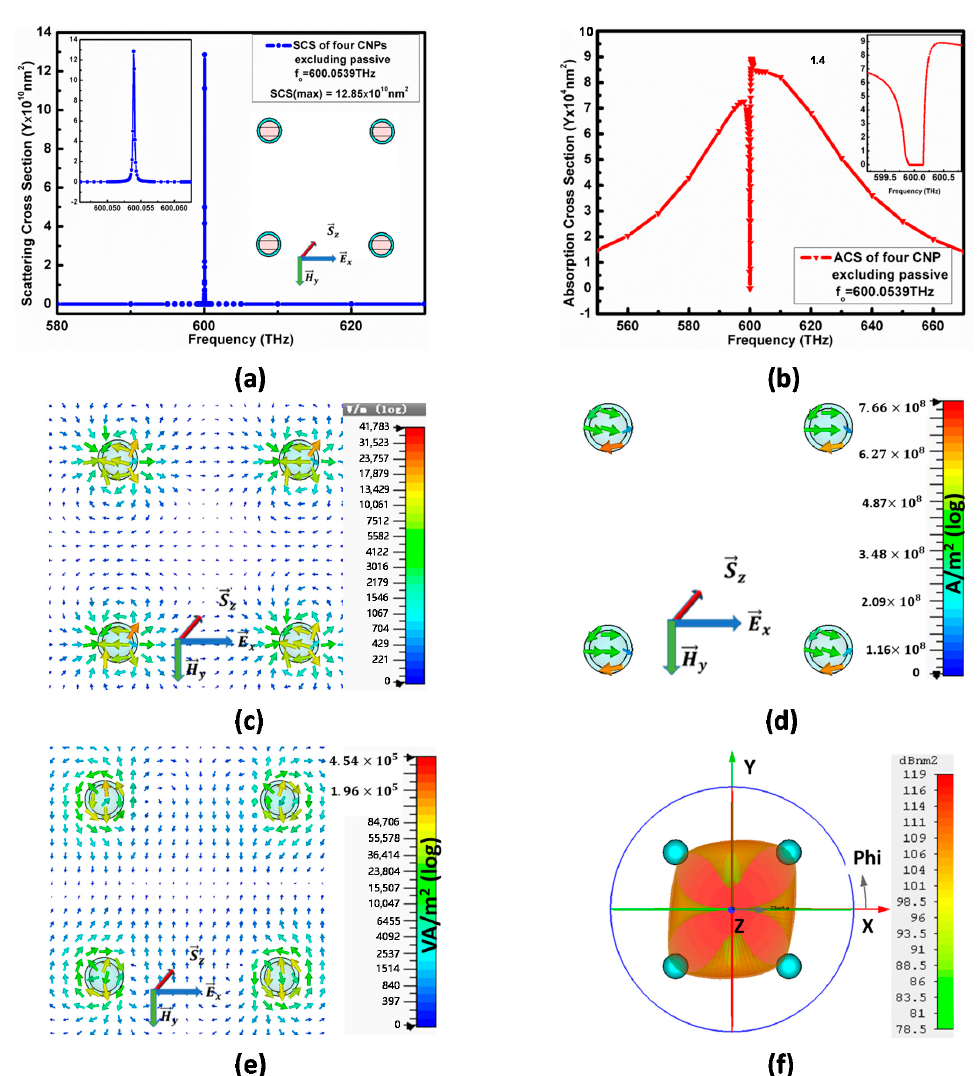
Figure 9. ( a ) shows schematics diagram of model-I along with SCS, while ( b ) gives its ACS. Figure 9 ( c , d ) explains the electric field and electric current density. Figure 9 ( e , f ) represents the power flow pattern and far-field pattern for model-I, respectively.